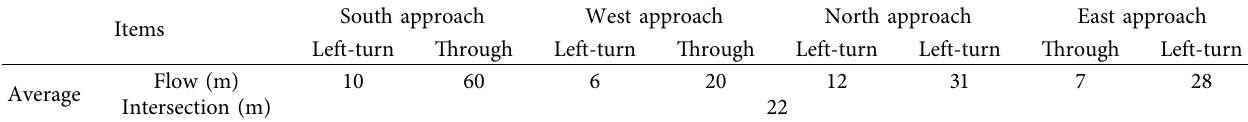
Table 7: Queue length of the Hongqi Street and Huaihe Road intersection after optimization.